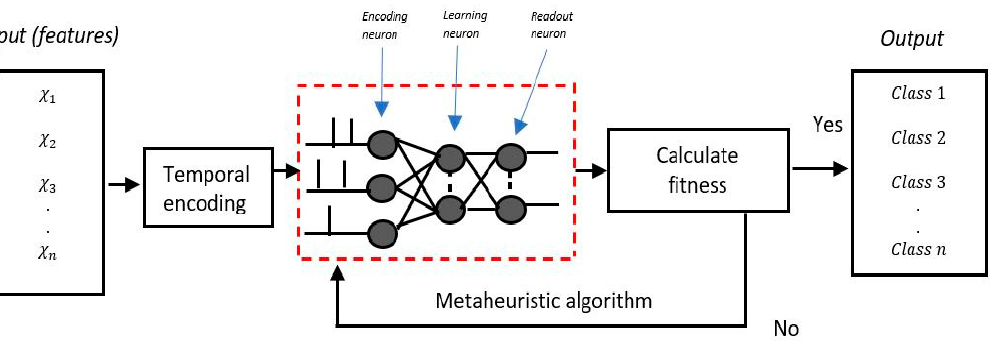
Figure 3. Generic schemes explaining the learning process of SNNs with metaheuristic algorithms.